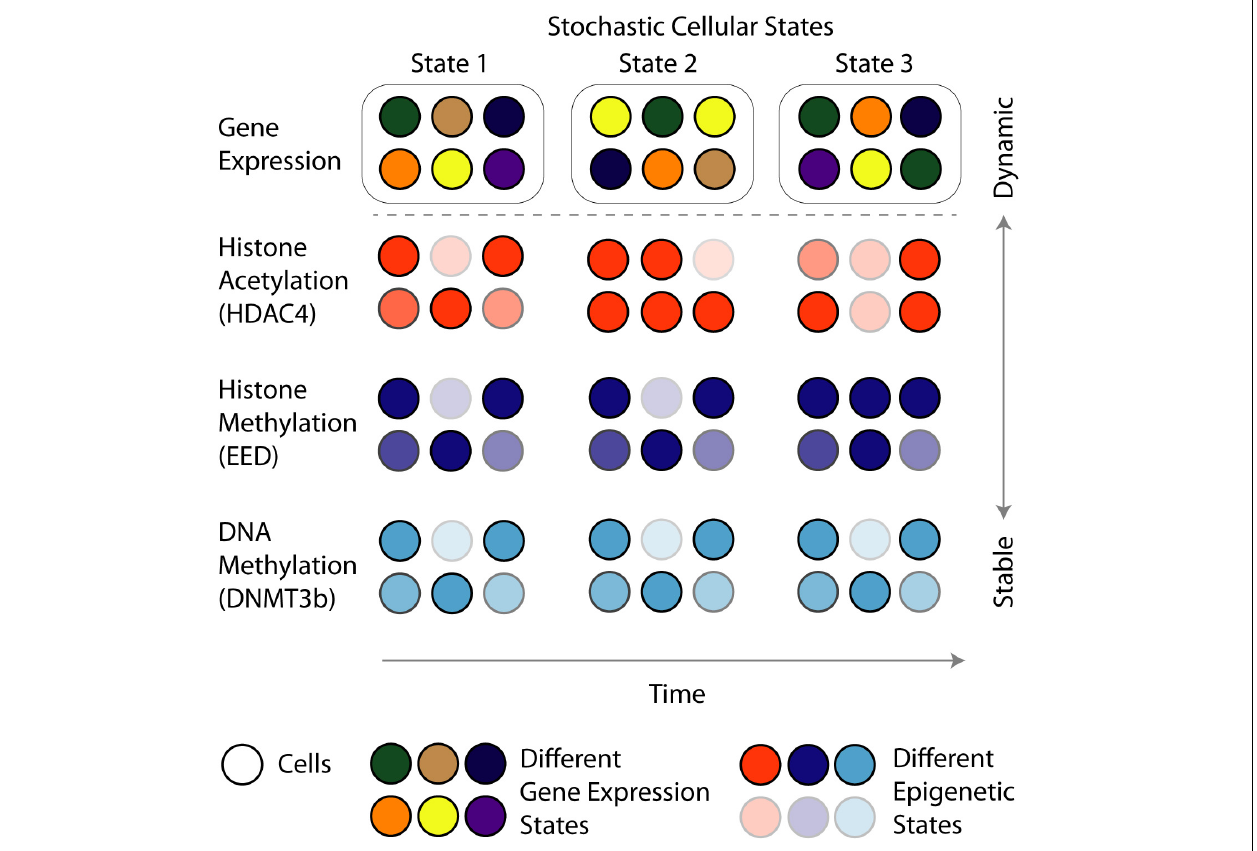
FIGURE 1 | Schematic depiction of how stochastic gene expression and epigenetic regulation creates mosaics of cells in different molecular states. Studies by Bintu et al. (2016) show that histone acetylation is dynamic and mediates short-term epigenetic memory, while histone and DNA methylation is more stable, mediating long-term epigenetic memory. These stochastic gene expression and epigenetic effects contribute to cellular diversity and may enable enhanced tumor cell diversity and